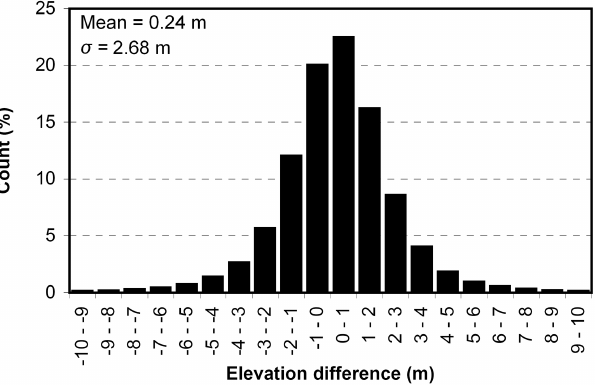
Figure 2. Histogram of elevation differences between 2009/2011 DEM and 1990 DEM over non-glacier-covered